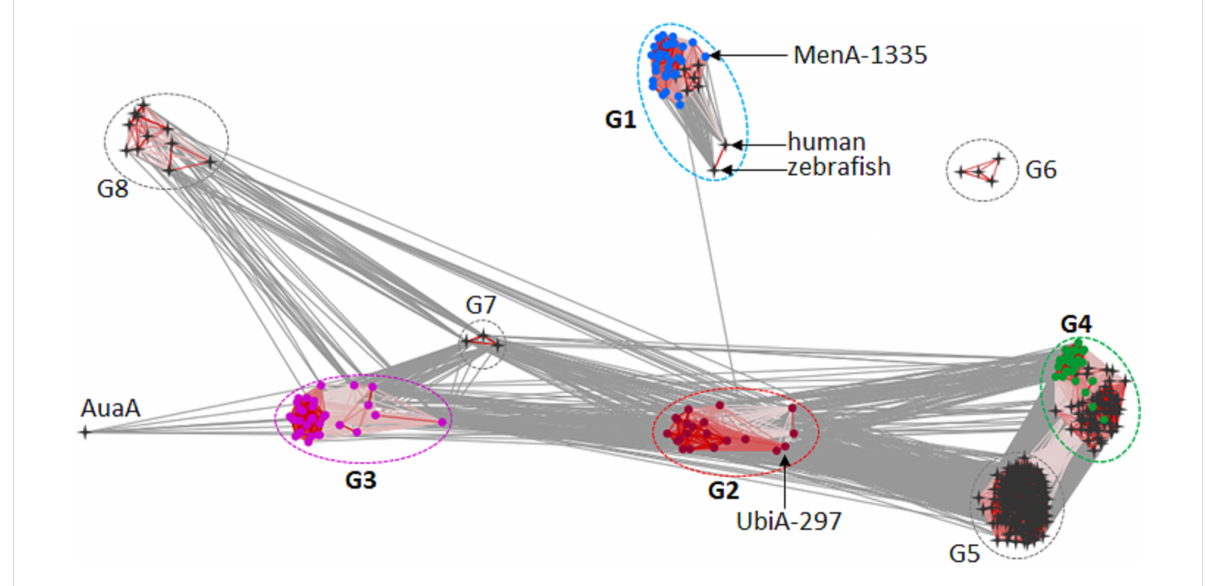
Figure 2: Homology clustering of Ptases encoded in marine Flavobacteria and Saccharomonospora species (G1–G4, colored nodes) and described Ptases in the Uniprot database (black 4-pointed stars). Visualization of the relationship between proteins is based on their all-against-all pairwise se- quence similarities using CLANS. The E-values lower than 1.0E − 6 were used to connect each sequence pair by edges. Edges color indicates pair- wise identities lower than 10% in grey, 10–45% in light red, and above 45% in dark red. G1: 1,4-dihydroxy-2-naphthoate polyprenyltransferase (blue nodes), G2: UbiA-like Ptases (red nodes), G3: ( S )-2,3-di- O -geranylgeranylglyceryl phosphate synthase (purple nodes), G4: protoheme IX farnesyl- transferase (green nodes), G5: 4-hydroxybenzoate octaprenyltransferase (bacterial and mitochondrial), G6: decaprenyl-phosphate phosphoribosyl- transferase, G7: chlorophyll synthase, and G8: homogentisate Ptases. AuaA is used as outgroup Ptase from Stigmatella aurantiaca